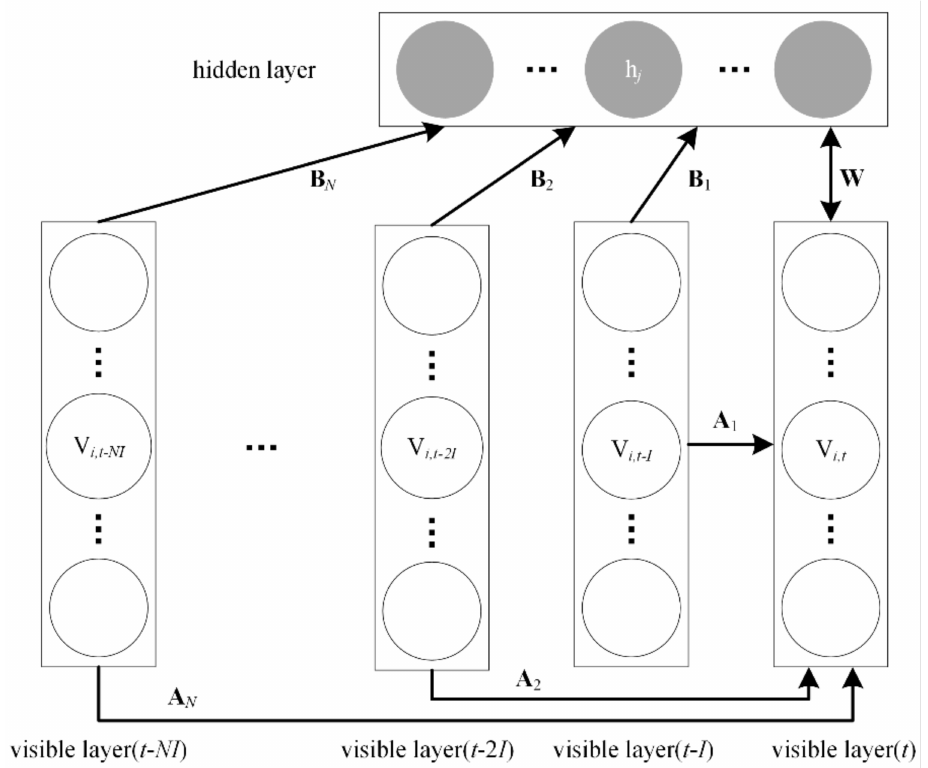
Figure 5. The structure of the